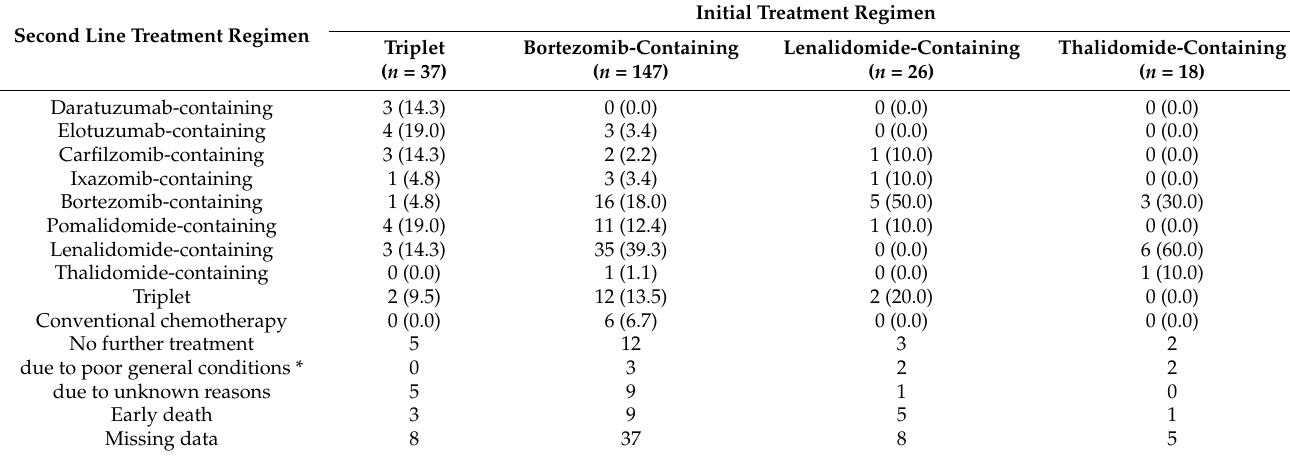
Table 2. Second line regimens in patients treated with novel agents as an initial treatment. Second Line Treatment